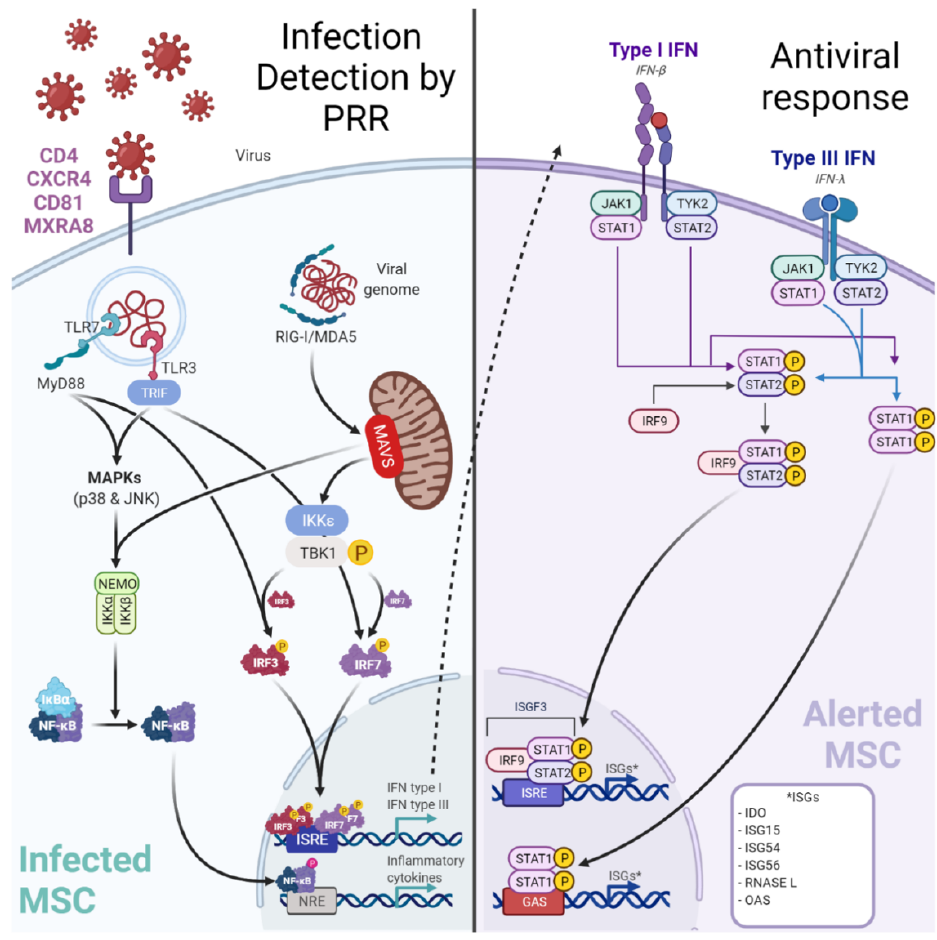
Figure 3. Infection of MSC by viruses may be controlled by a canonical innate immune